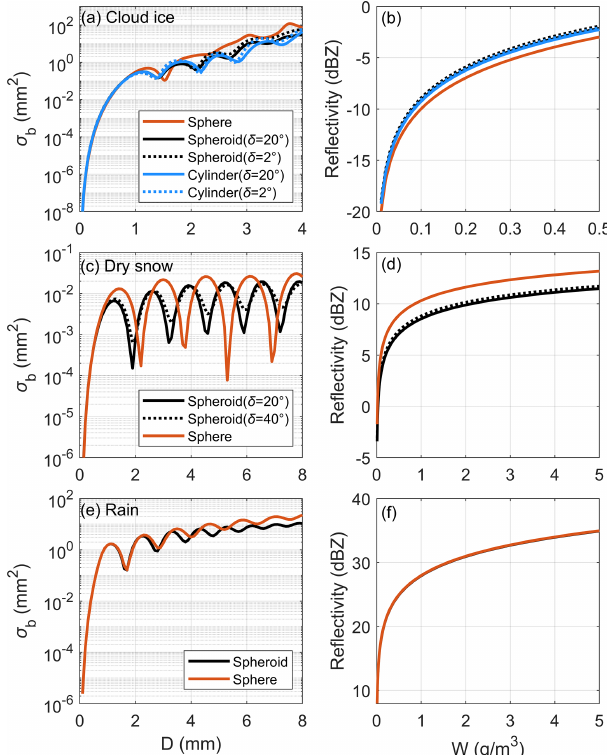
Figure 6. Backscattering cross section and corresponding radar re- flectivity under different shapes for cloud ice, dry snow, and rain. (a) Comparison of the backscattering cross sections of ice crys- tals as spheres, spheroids, or cylinders, where δ is the SD of the canting angle. (b) Radar reflectivity comparison for particles in (a) , where the PSD was assumed to be a gamma distribution con- strained by Eqs. (7)–(9), with µ = 1 and T =− 60 ◦ C. (c) Compar- ison of the backscattering cross sections for dry snow with spheres and spheroids. (d) Radar reflectivity comparison for particles in (c) , where the PSD was assumed to be an exponential distribution with N 0 = 3 × 10 3 m − 3 mm − 1 . (e) Comparison of backscattering cross sections for raindrops with spheres and spheroids. (f) Radar reflec- tivity comparison for particles in (e) , where the PSD was assumed to be a gamma distribution with D 0 = 1.25mm and µ =